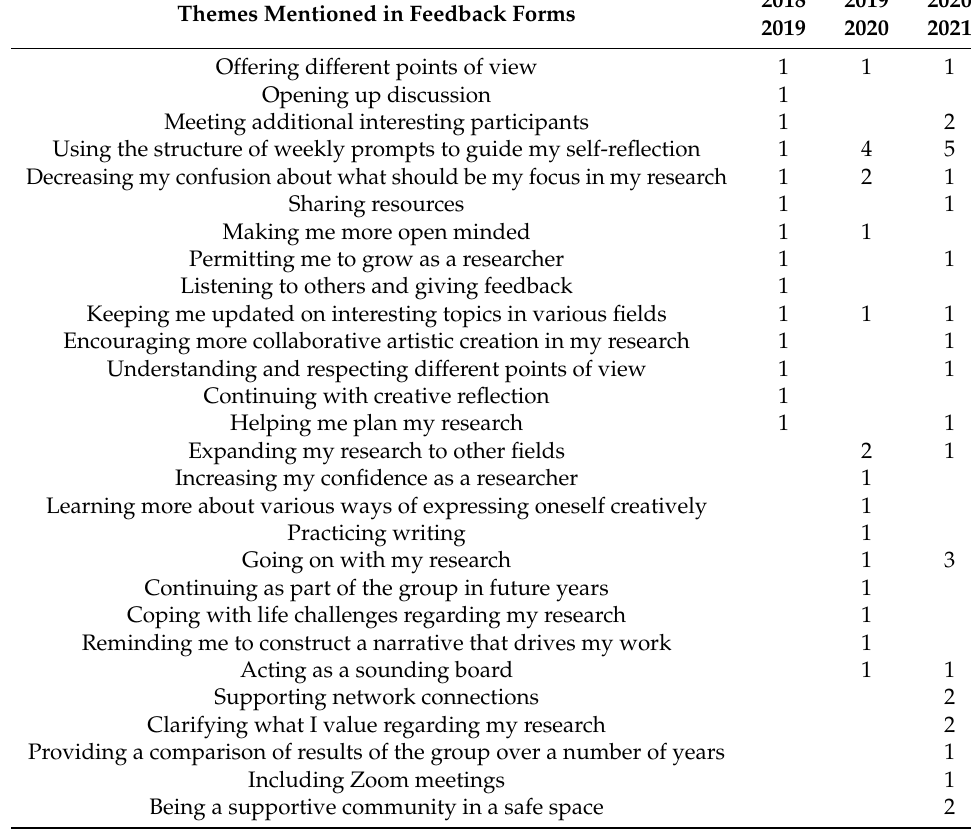
Table 9. Themes Mentioned in Responses Provided on the April Feedback Forms to How Might the HeNReG be of Help to You in the Future? For Each of the Three Most Recent Academic Years in Order of Receipt of Feedback Forms from Group